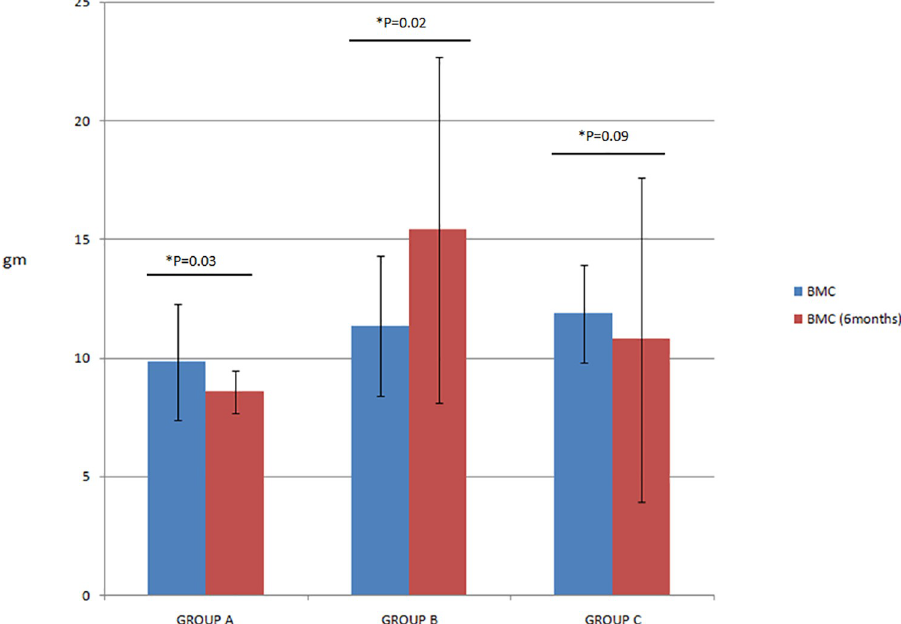
Fig 3. Bone mineral content in study groups at randomization and after 6 months. Group A- Methylprednisolone; Group B- Zoledronate; Group C-